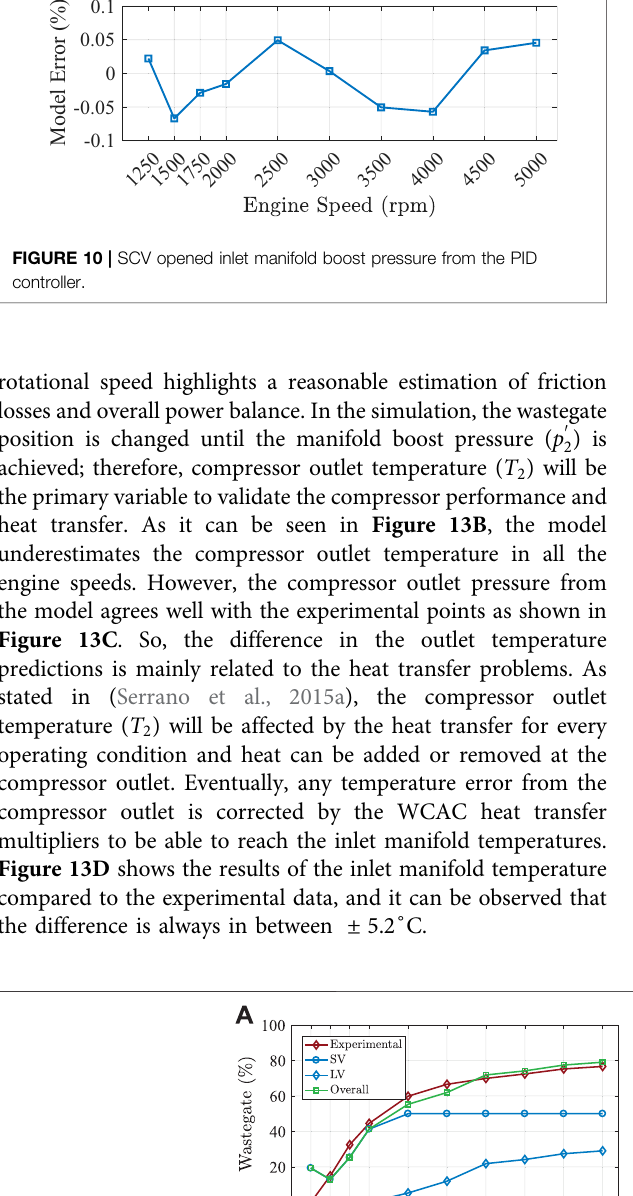
Frontiers in Mechanical Engineering |